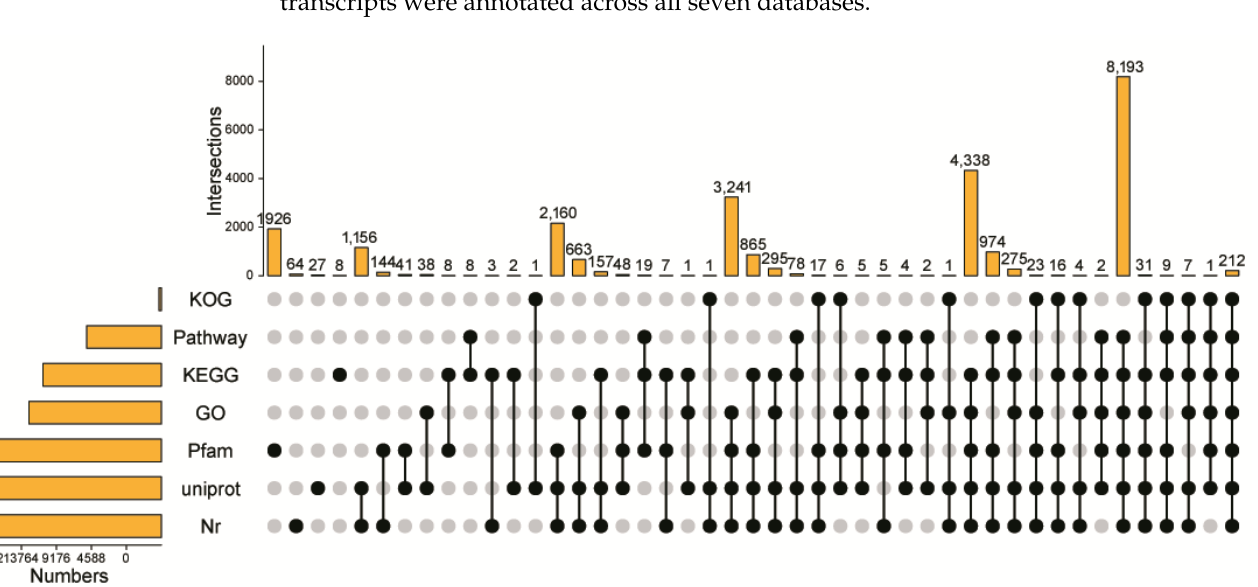
tion mechanism (Figure S6).